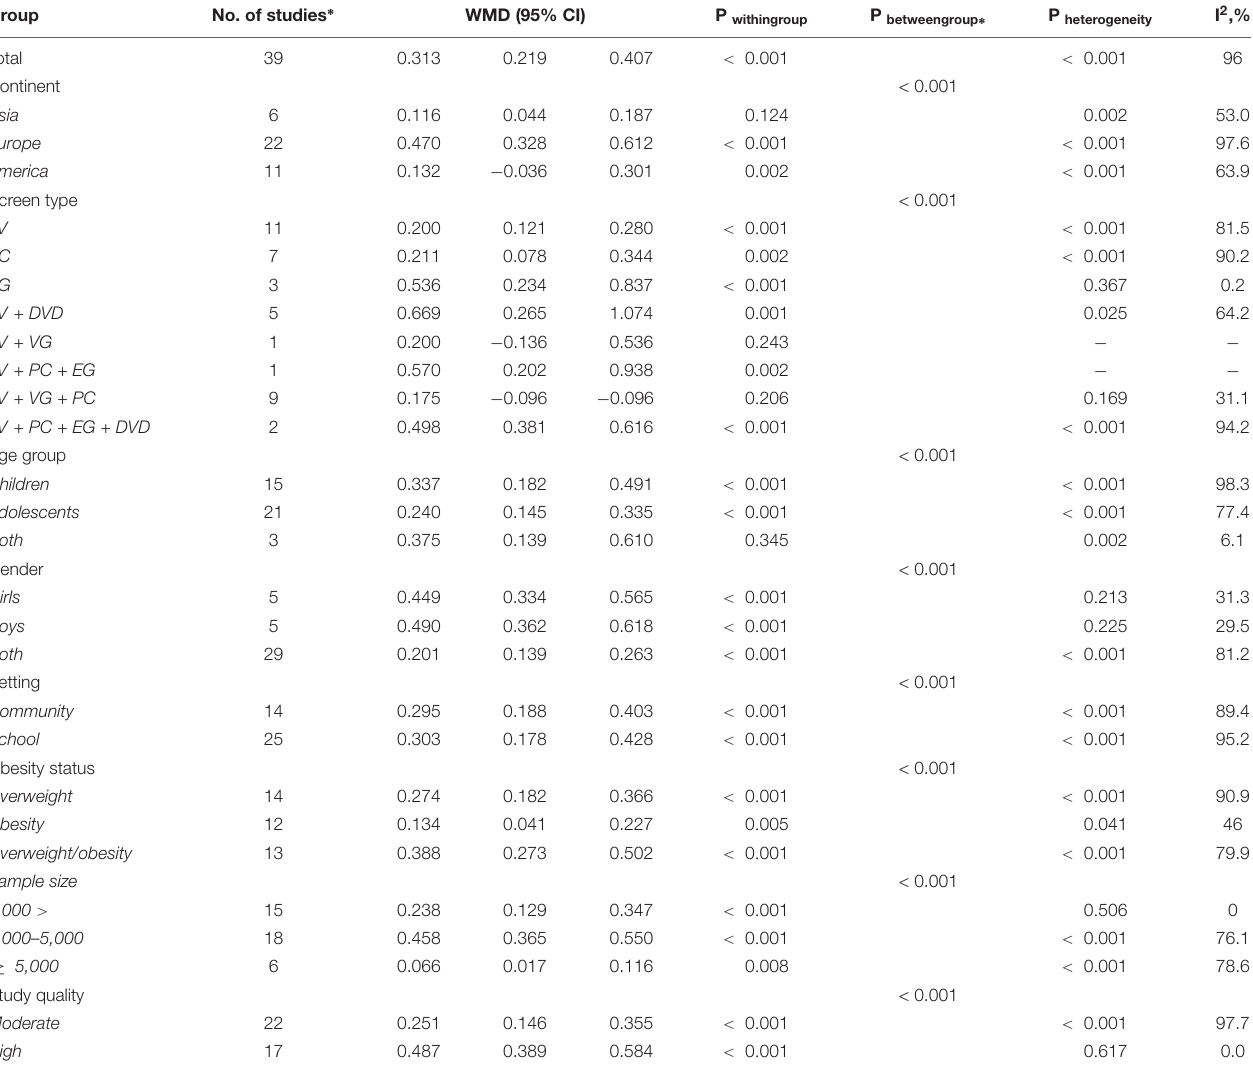
TABLE 5 | Subgroup analysis for the comparison of screen time among overweight/obese vs. non-overweight/obese children and adolescents. Group No. of studies ∗ WMD (95% CI) P